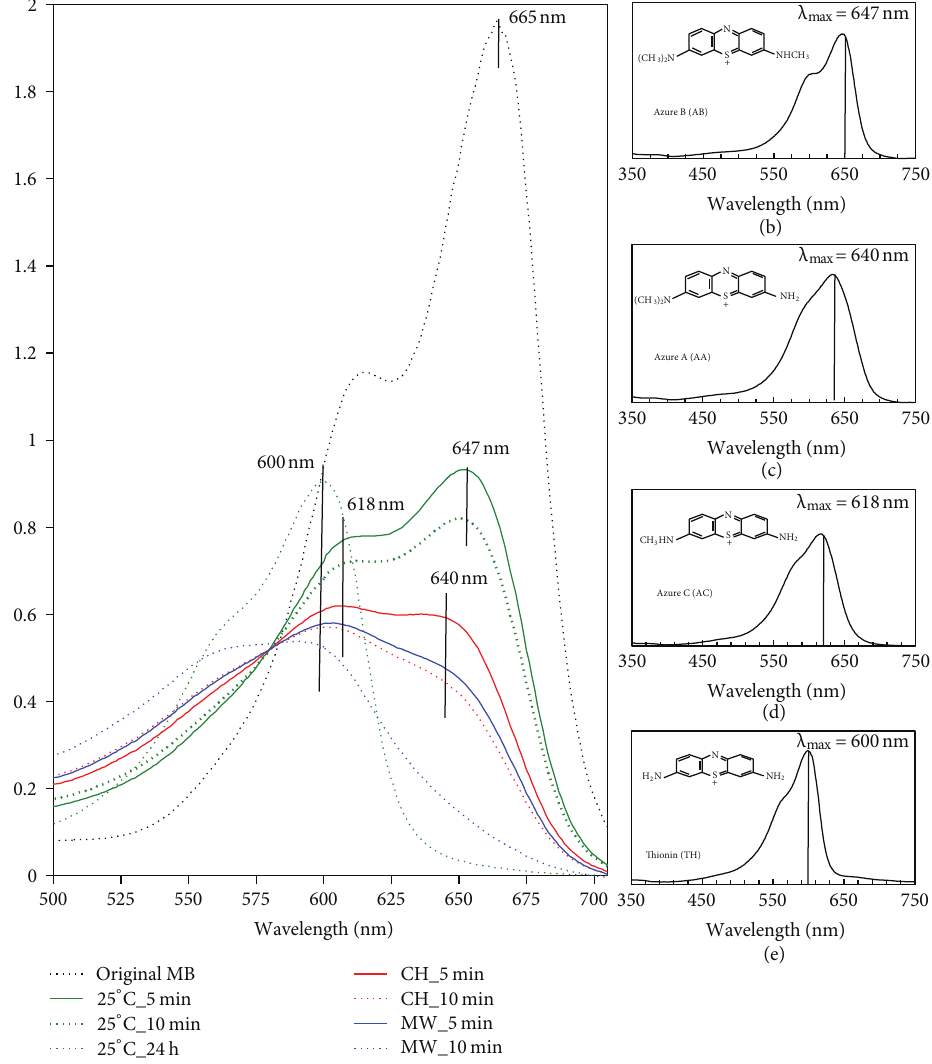
F 6: (a) UV-vis spectroscopy of MB aer different reaction times under various radiation conditions, compared to (b) AB, (c) AA, (d) AC, and (e) TH standard compounds in aqueous